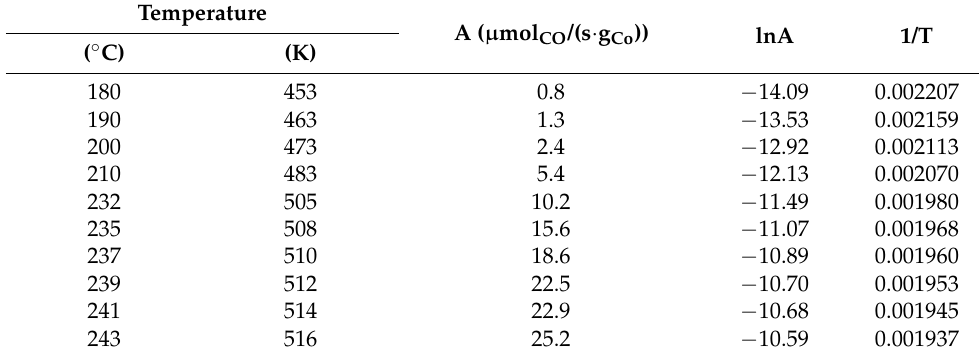
Table 4. Temperature dependence of catalyst B activity (A) at 300 h − 1 and 2